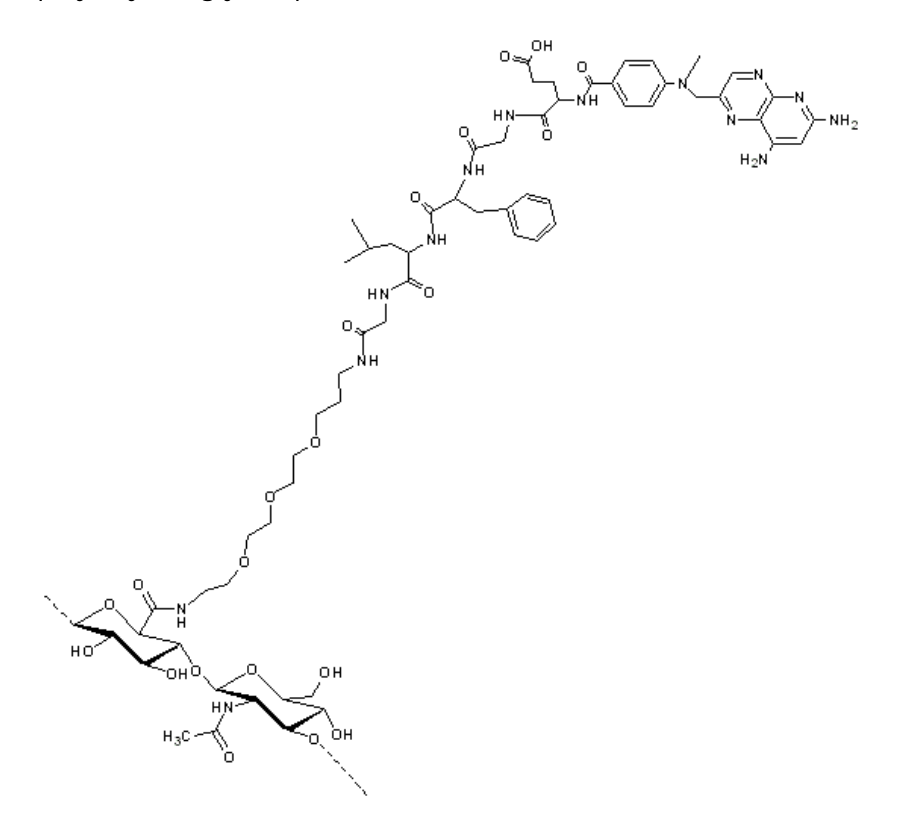
Figure 8. HA–methotrexate (MTX) conjugate: MTX was firstly linked to a lysosomal enzyme-sensitive peptide linker (Gly-Phe-Leu-Gly) that was further conjugated to HA by means of a polyethylene glycol spacer